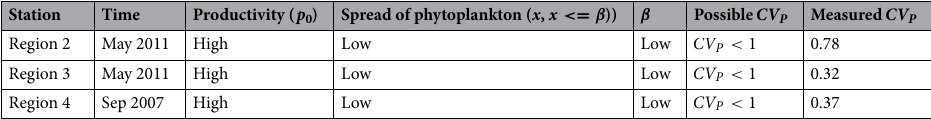
Table 4. CV P < 1 : nature of phytoplankton productivity and spreading triggered by regional and seasonal